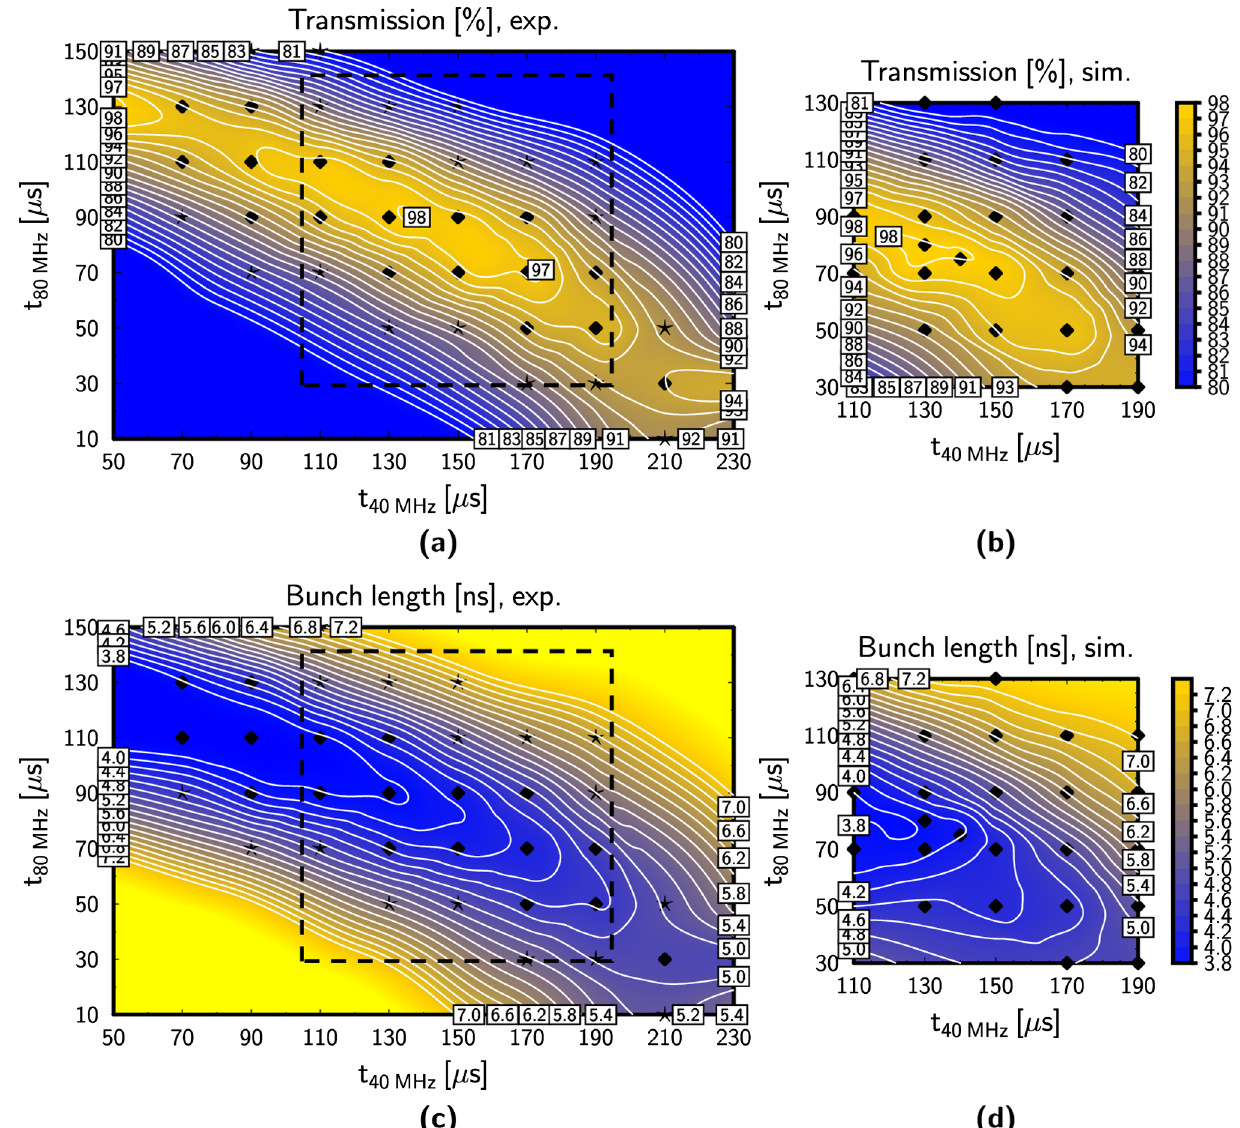
FIG. 5. Contour plots of transmission (a), (b) and bunch length (c), (d) ( 4 (cid:1) Gaussian fit) as a function of PS rotation timings for ¼ 600 kV and V ¼ 600 kV . Measured and simulated results are shown in parts (a), (c) and (b), (d), respectively. In (a) V 40 MHz 80 MHz and (c), measurements points marked with stars are averages of five measurements, while diamonds mark an average of ten; the boxes mark the region that was also simulated. Measurements were done with a 50 ns spaced beam at an intensity of 1 : 6 (cid:1) 10 11 p = bunch